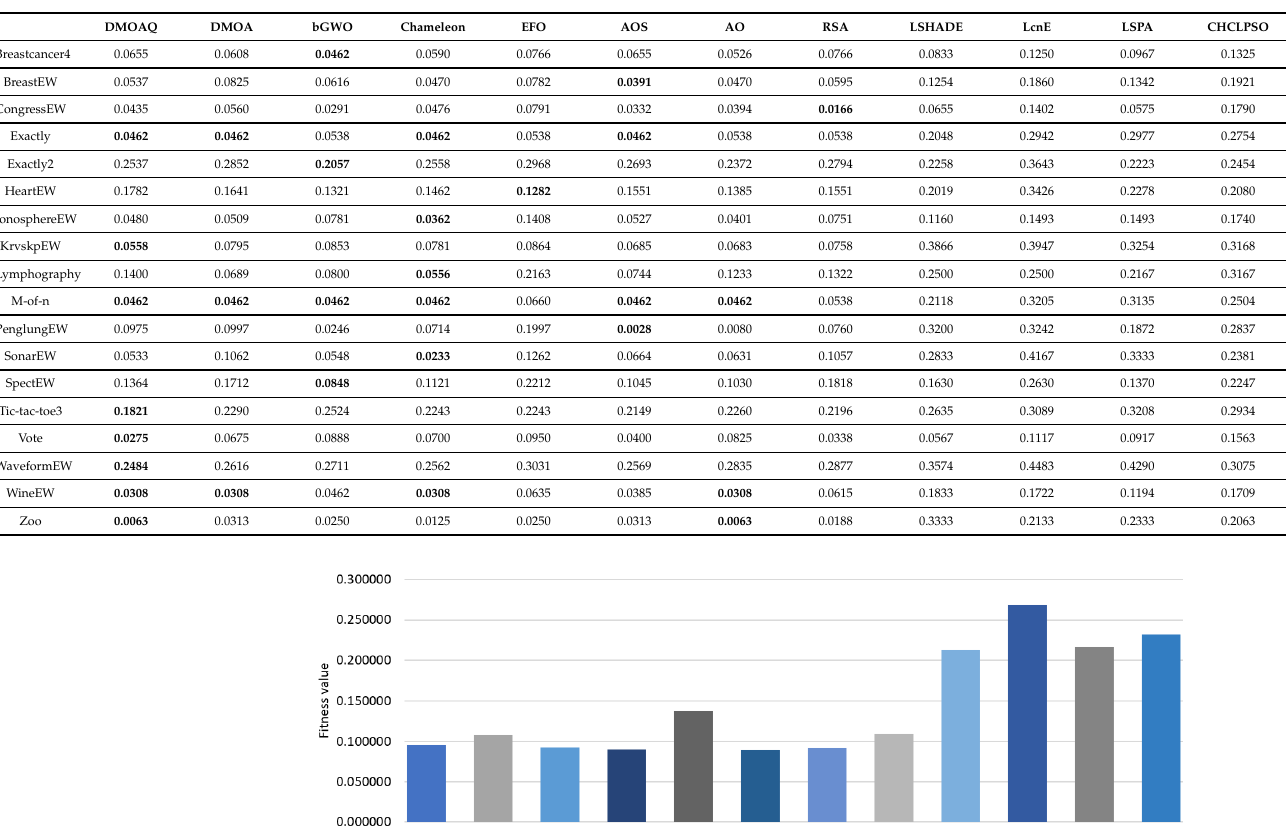
Figure 3. Average of the standard deviation of the fitness function. Moreover, the best results of the fitness function values are recorded in Table 5. This table indicates that the proposed DMOAQ obtained the minimum fitness values in 8 out of 18 datasets. It was ranked first with obtaining the best Min results in Exactly, KrvskpEW, M-of-n, Tic-tac-toe3, Vote, WaveformEW, WineEW, and Zoo. The Chameleon showed the second-best results and obtained the best values in 6 out of 18 datasets. Both bGWO, AOS, and AO were ranked third, fourth, and fifth, respectively. The worst per- formances were shown by LSHADE-cnEpSin, LSHADE, and LSHADE-SPACMA. Figure 4 illustrates the minimum average of the fitness functions for all datasets for this measure. Table 5. Minimum of the fitness function values.